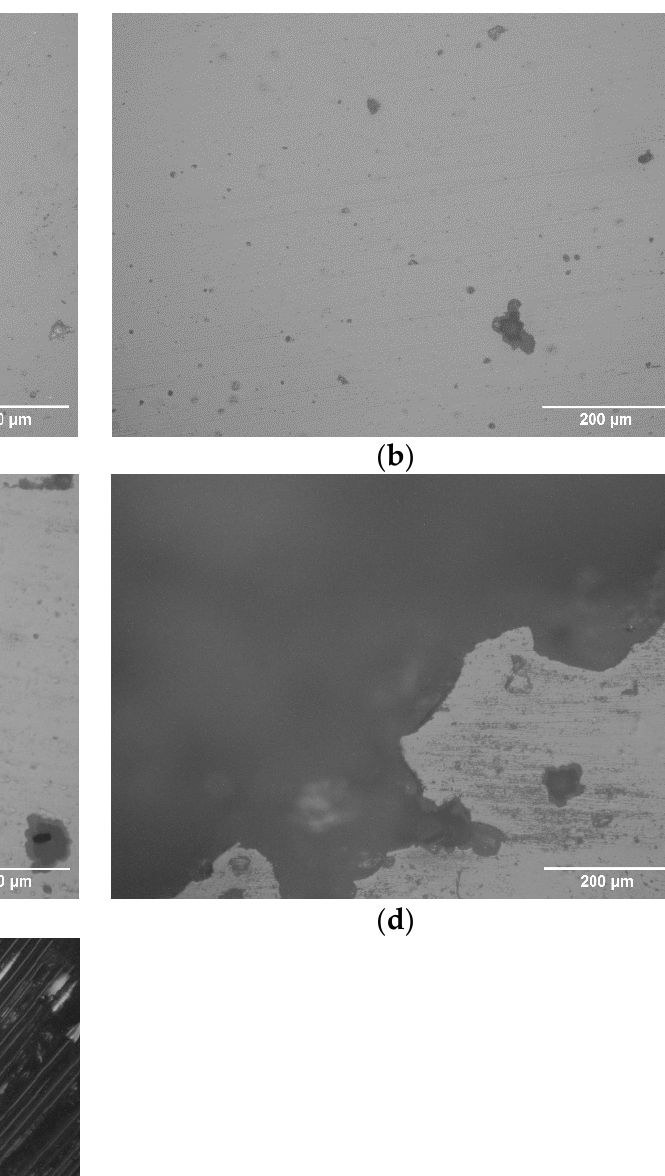
Figure 10. Microcopy image of representative sample with coating B at ( a ) stage 1; ( b ) stage 2; ( c ) stage 3; ( d ) stage 4; ( e ) stage 5.